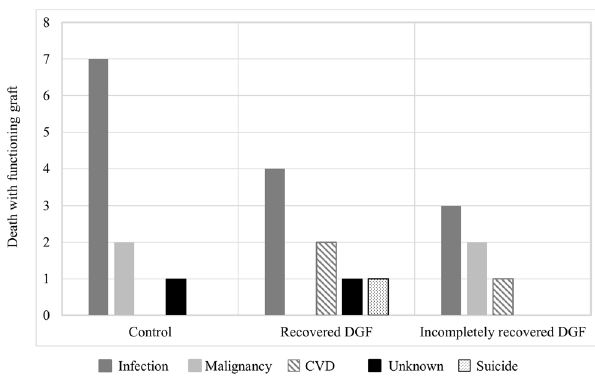
Figure 3. Causes for patient death. CVD: cardiovascular diseases.